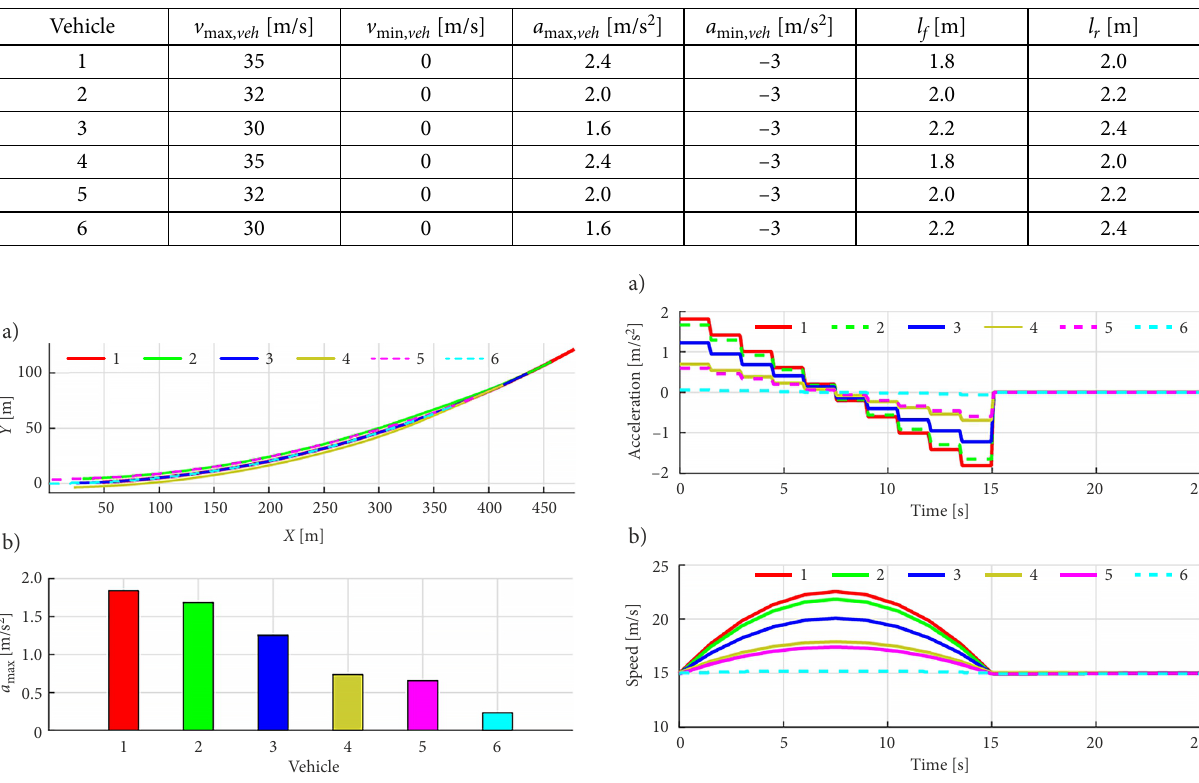
Figure 15. Planned paths and maximum resultant accelerations Figure 16. Planned longitudinal accelerations and speeds